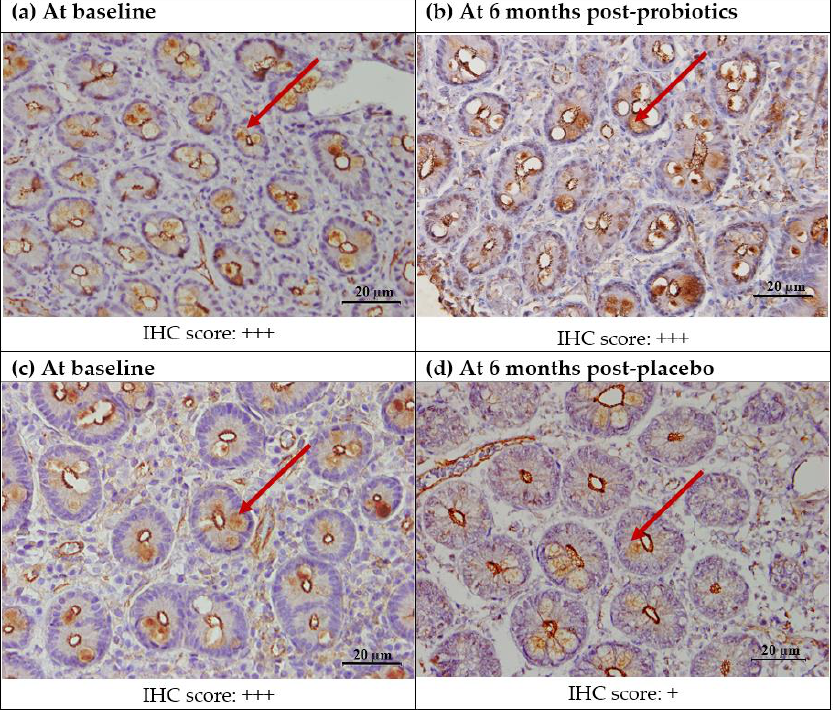
Figure 6. Immunohistochemical staining of tight junction zonula occluden-1 (ZO-1) protein in the duodenal mucosa (ZO-1400X). ( a ) Duodenal mucosa of a patient with NAFLD at baseline. ( b ) Duodenal mucosa of a patient with NAFLD after 6 months of probiotics. ( c ) Duodenal mucosa of a patient with NAFLD at baseline. ( d ) Duodenal mucosa of a patient with NAFLD after 6 months of the placebo. Brownish ZO-1 IHC staining was observed in the intestinal crypts (red arrows). There was a significant reduction in ZO-1 expression in the post-intervention placebo group (Z-score = −2.86, p = 0.04) but not in the probiotics group (Z-score = −0.93, p = 0.35). Staining score: 0: complete loss; +: moderate loss; ++: focal loss; +++: very focal loss; and ++++: no loss.